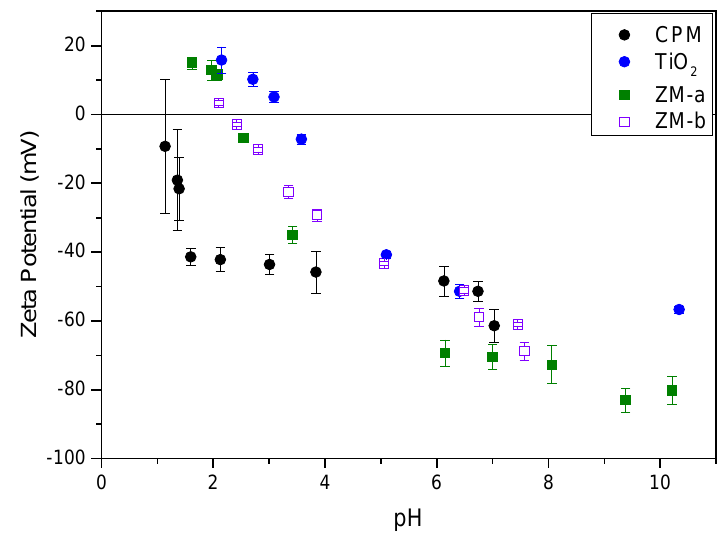
Figure 8. Zeta potential curves for caesium phosphomolybdate (CPM), titanium dioxide (TiO 2 ) and zirconium molybdate (ZM-a and ZM-b) measured at concentrations of 1000 ppm in 10 − 4 M potassium nitrate (KNO 3 ) solution.